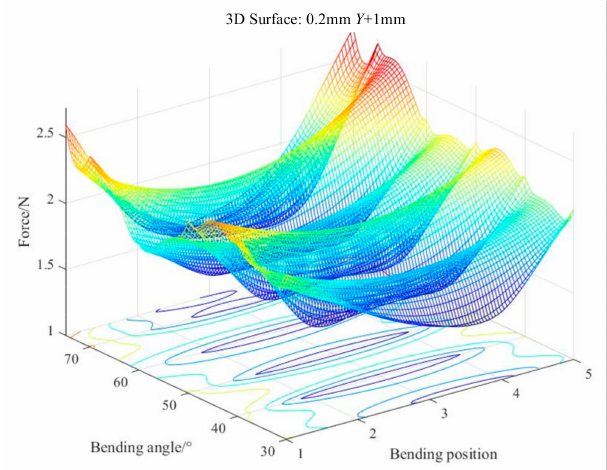
Figure 8. Driving force required to move 1 mm in the Y -direction.